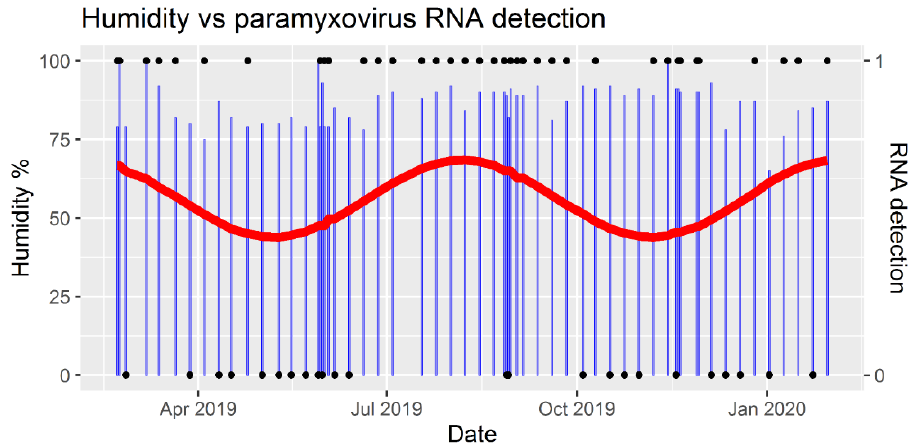
Figure 4. Detection of paramyxovirus RNA in pooled urine and air humidity over time. RNA detection (black dot at 1) means that at least one of the five samples collected in the sampling event tested positive for viral RNA; negative detection (black dot at 0) means that no paramyxovirus RNA was detected. Air humidity (blue bars) was recorded at the time of sample collection. The red line represents seasonal variation in RNA detections and was derived from a sinusoidal regression model with a biannual wave ( p -value for the sine-wave = 0.003).